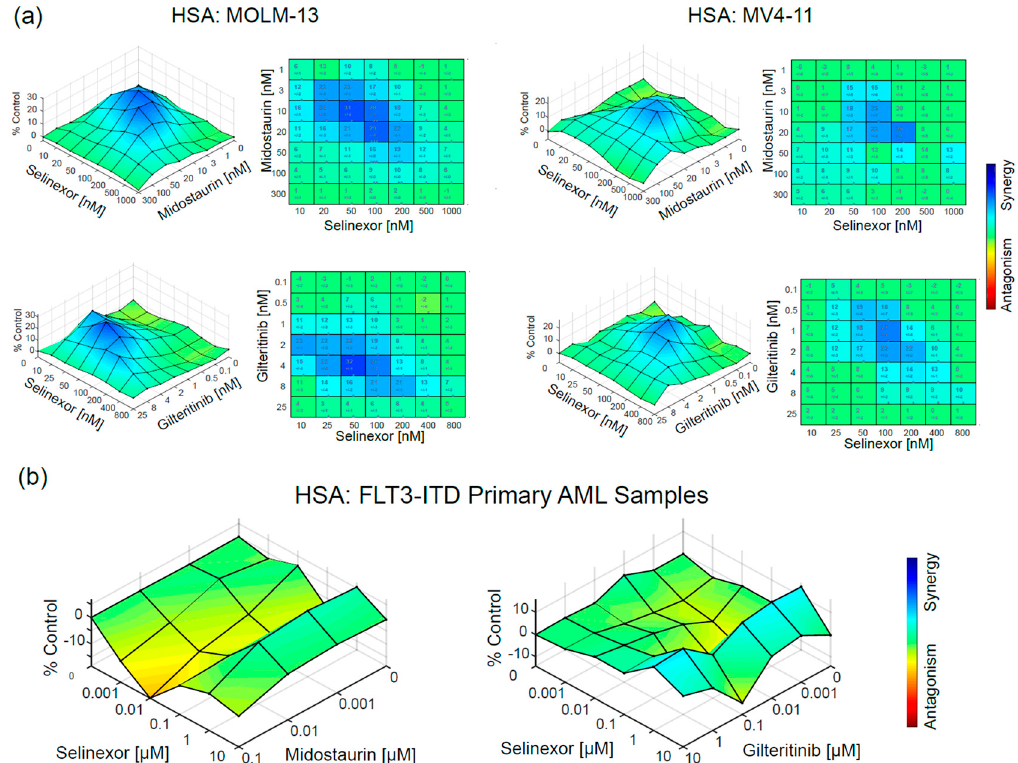
Figure 3. In vitro pharmacologic validation of XPO1 as a cotarget with FLT3. ( a ) MOLM-13 or MV4-11 cells were treated with a range of doses of midostaurin or gilteritinib plus selinexor for 48 h and proliferation changes measured. Regions of synergy were determined using highest single agent analysis shown here; mathematical synergy was calculated in Figure S3. ( b ) Similar proliferation and synergy analysis was applied to primary FLT3 -ITD AML patient samples, AML1 and AML2, which were cocultured with HS5 stromal cells for 96 h. For each drug ( n = 2 patient samples), blast cells were separated from stroma prior to development with MTS and results averaged prior to analysis against a highest single agent model shown here; mathematical synergy was calculated in Figure